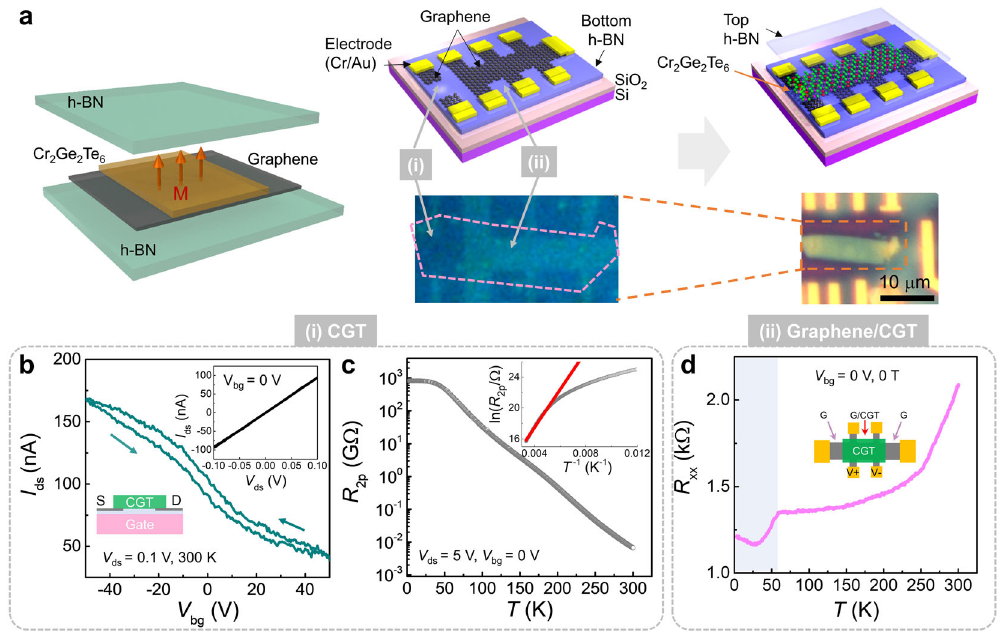
Fig. 1 Fabrication of graphene/CGT heterostructures and temperature-dependent resistance of pristine CGT and graphene/CGT. a Conceptual drawing of the heterostructure (left), optical and schematic images of patterned graphene (center) and graphene/CGT (right) for sample D1; (i) and (ii): patterned graphene used to study the electrical properties of pristine CGT and graphene/CGT, respectively. b Transfer characteristic curve ( I ds vs. V bg ) of CGT exhibiting p -type behavior. The lower left inset is a side-view schematic of the CGT transistor with a graphene electrode. The upper right inset shows the I ds – V ds curve of CGT measured using the graphene electrode in 2P con fi guration. c Temperature-dependent resistance of CGT at V ds = 5 V and V bg = 0 V. The inset shows the Arrhenius plot of the results, where the red fi tted line yields an energy gap of ~0.42 eV. d Temperature-dependent R xx of graphene/CGT at V bg = 0 V and 0 T. The inset shows a top-view schematic of the measurement con fi